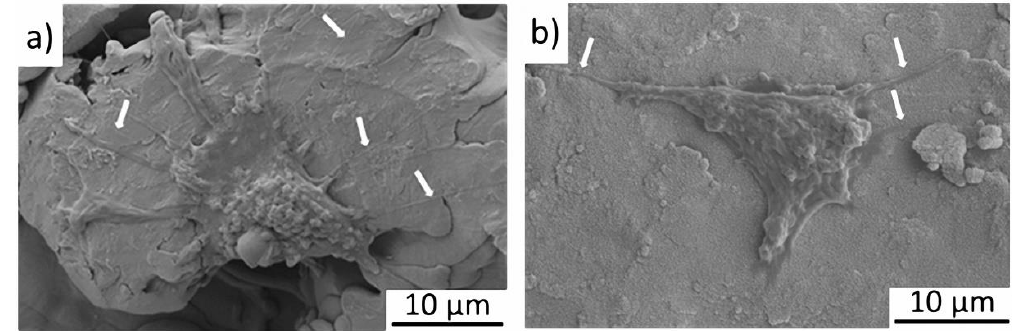
Figure 4. SEM images of adherent MSC on ( a ) the TPS structure and ( b ) the TPS+ structure. White arrows indicate pseudopodia of the cells.